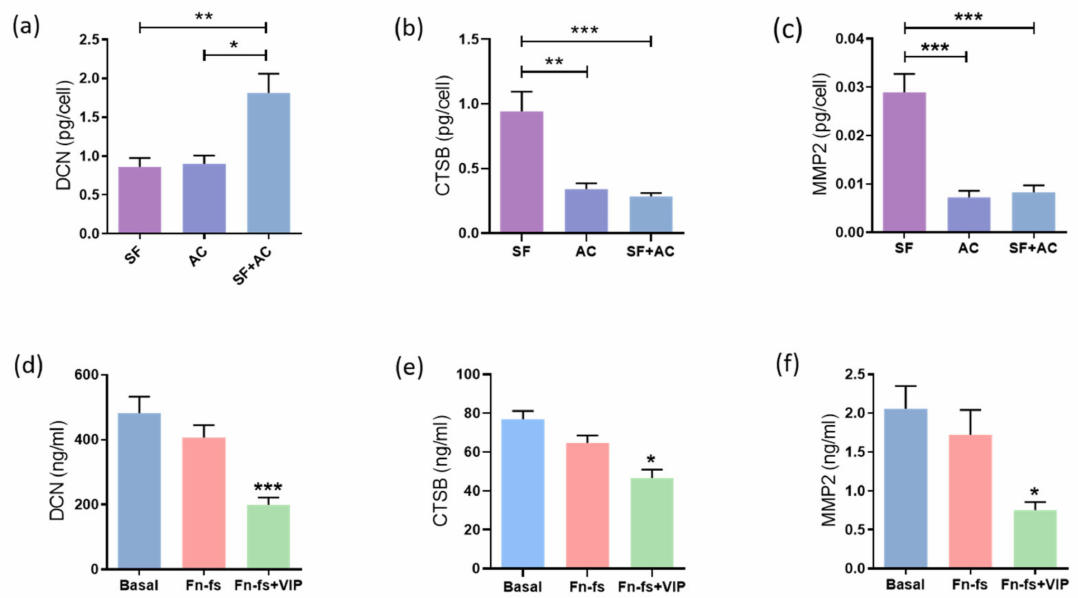
Figure 5. VIP-modulated ECM degradation proteins. Secreted levels of ( a , d ) DCN, ( b , e ) CTSB, and ( c , f ) MMP2 were determined by ELISA and Multiplex, respectively, in the secretomes from SF and AC alone and in co-culture ( n = 6). Data are presented as mean ± SEM of triplicate determinations. ( a – c ) Constitutive protein expression of ( a ) DCN, ( b ) CTSB, and ( c ) MMP2 in the secretomes from SF and AC alone and in co-culture at 48 h. * p < 0.05, ** p < 0.01, *** p < 0.001. Results are presented as pg corrected by the number of cells for each condition. ( d – f ) Protein expression of ( d ) DCN, ( e ) DCN, and ( f ) MMP2 in the SF-AC co-cultures secretomes at 48 h of treatment with and without 10 nM 45 kDa Fn-fs in the presence and absence of 10 nM VIP. * p < 0.05, *** p < 0.001 Fn-fs+VIP vs.